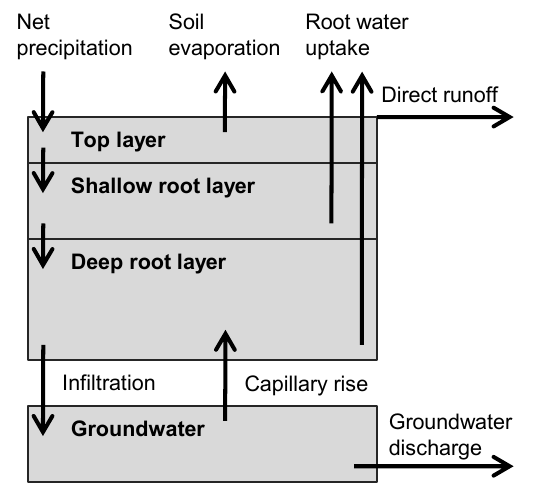
Figure 2. Schematization of the structure of AWRA-L showing the three soil layers, groundwater store, and the relevant hydrological fluxes. Net precipitation refers to the precipitation reduced by inter-